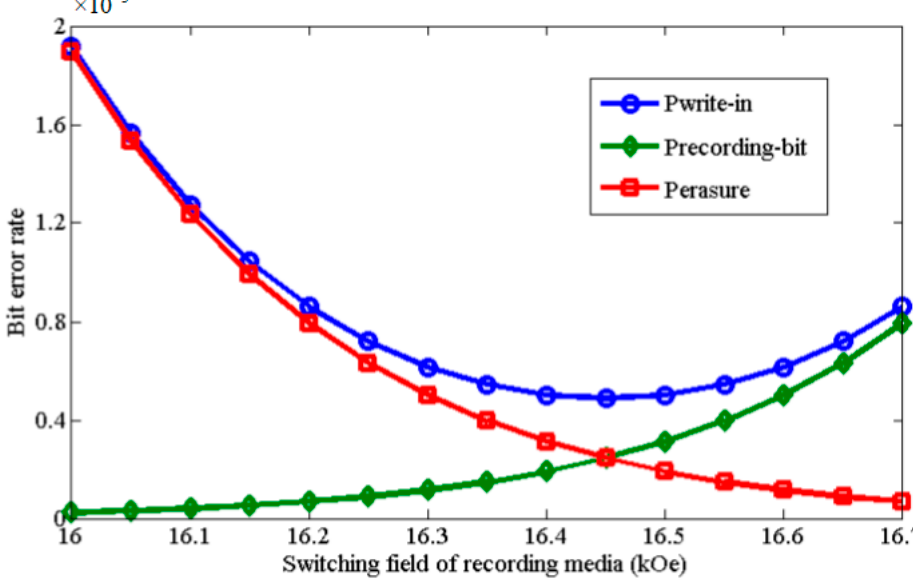
Figure 4. Bit error rate versus switching field of recording media.